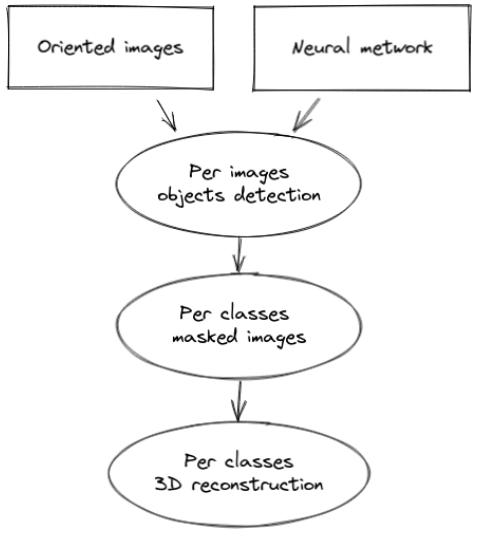
Figure 8: (Top) 3D reconstructed stocks, (Center) individualized objects (one color per stock), (Bottom) and the result of the 3D registration (greeen : reference, and red : target datasets). grouped by 3, then each target group is aligned successively with the 3 closest groups of the reference data set (current one, previ- ous and next ones in the row), see Figure 9.